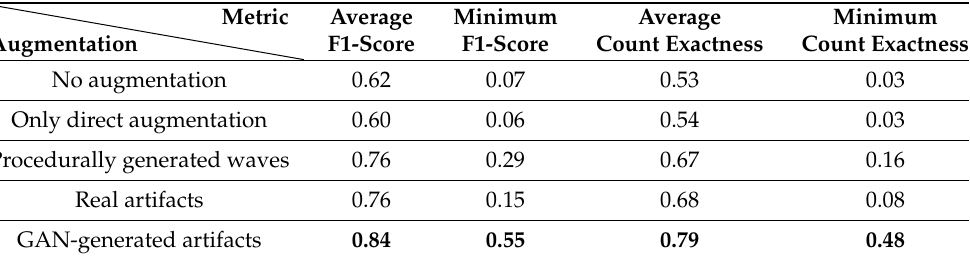
Table 2. F1-score and count exactness values measured after training with the presented augmenta- tion methods. The best results are written in bold.